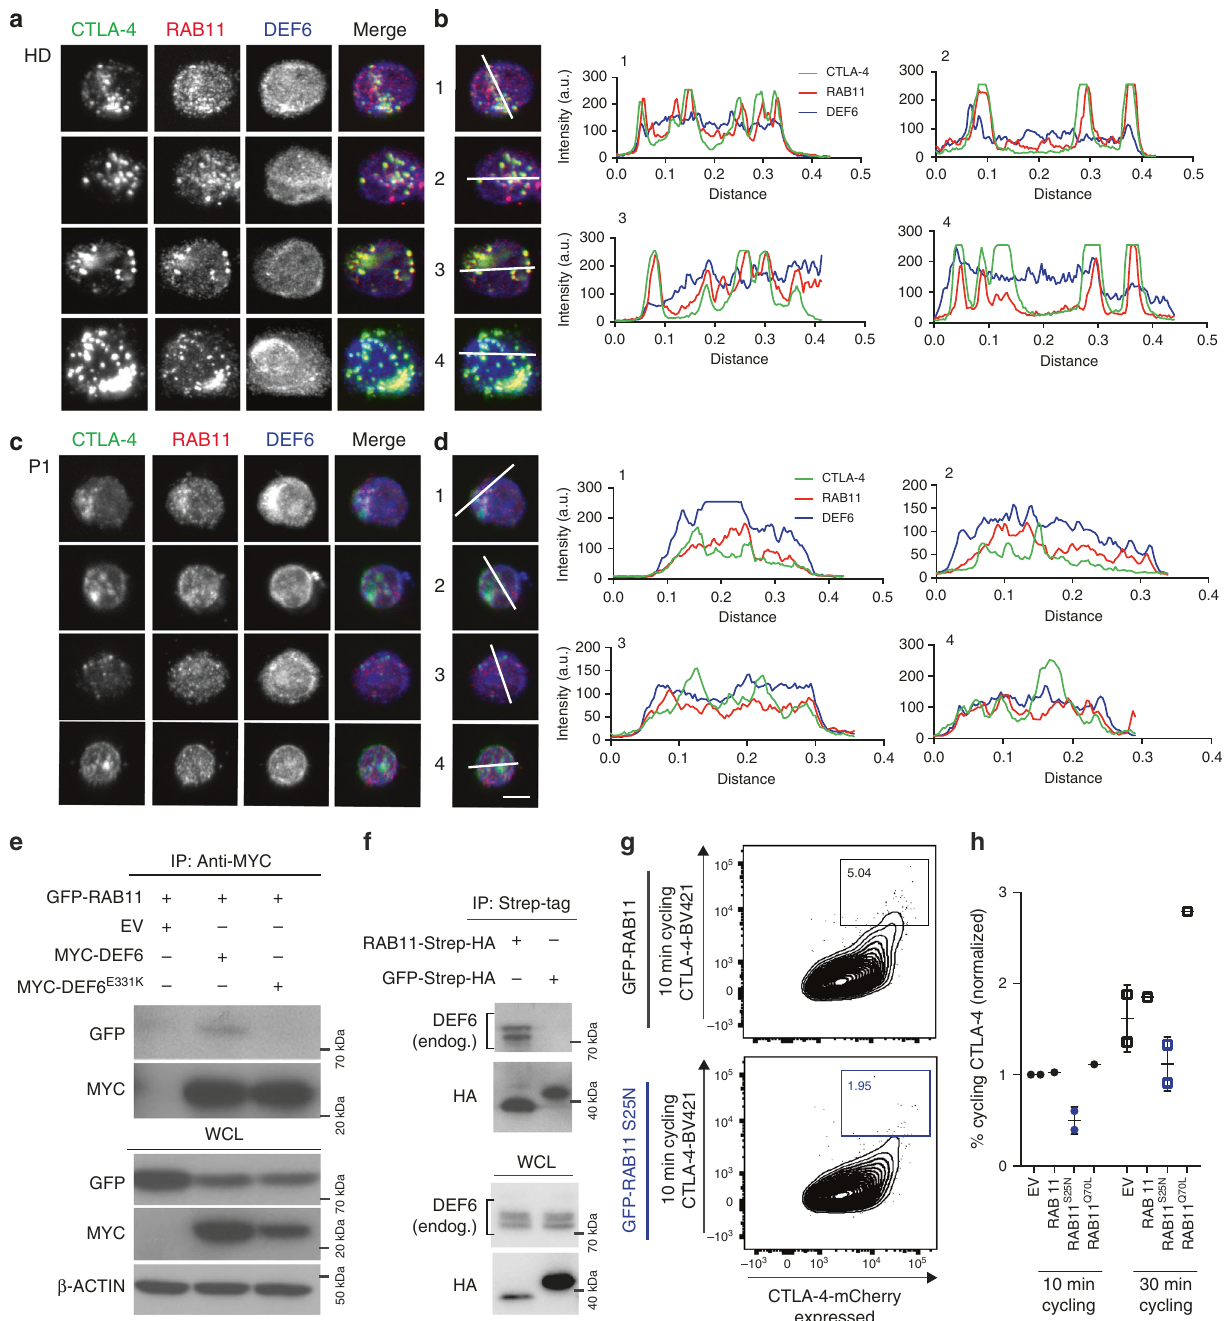
Fig. 6 DEF6 mutations affect RAB11 interactions. a Representative images of endogenous CTLA-4, and RAB11 and DEF6 in TCR-stimulated healthy control (HD) PBMCs showing RAB11-CTLA-4 co-localization. b Line scans of images in ( a ) reveal high overlap of RAB11 and CTLA-4 signal in activated HD-